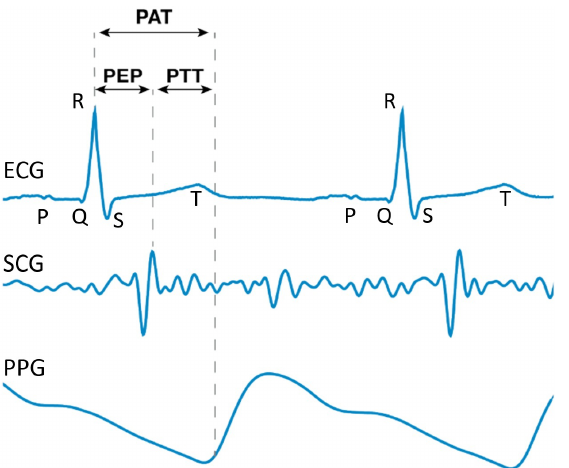
Figure 2. This figure shows waveforms from various measurements and the relation between PAT and PTT as in Equation (1). ECG = electrocardiography, SCG = seismocardiography, and PPG = pho- toplethysmography. The letters in the ECG waveforms represent the parts of the